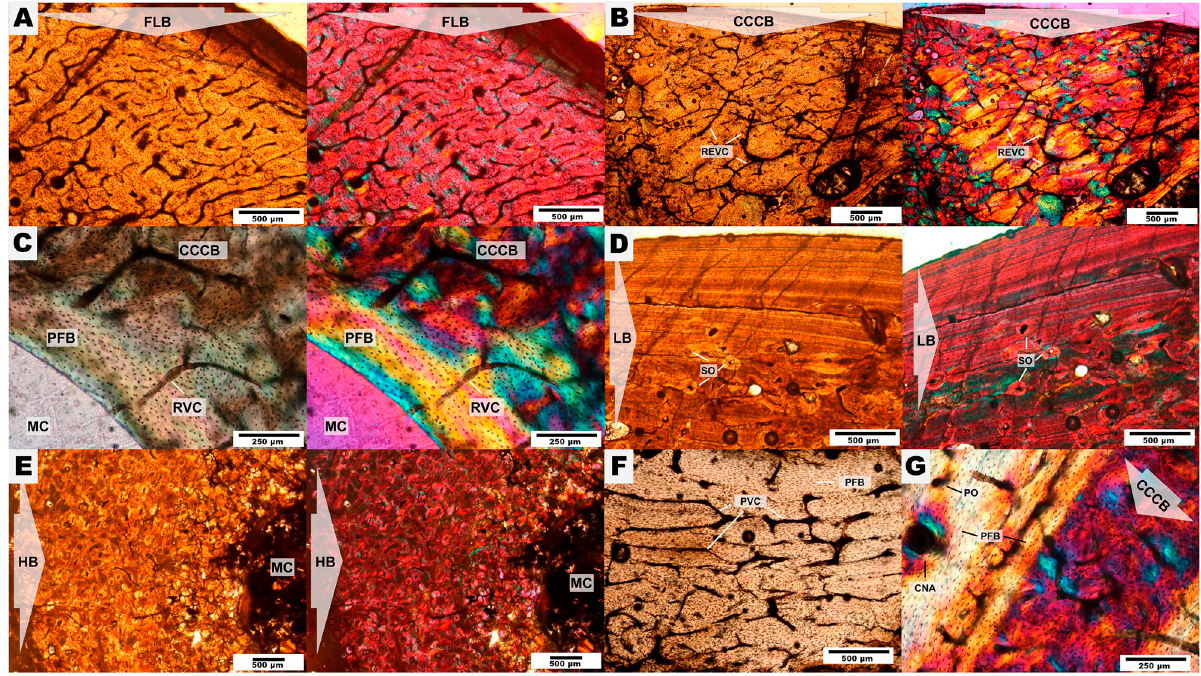
Fig 4. Bone tissue types observed in Caraguatypotherium munozi . (A) Fibrolamellar bone (FLB);(GEOUACH.HS.UD.1); (B) Compacted coarse cancellous bone (CCCB) and reticular vascular canals (REVC);(GEOUACH.HS.UD.1); (C) Parallel fibered bone (PFB), radial vascular canals (RVC) and compacted coarse cancellous bone (CCCB);(GEOUACH.HS.PFD.1); (D) Lamellar bone (LB) and secondary osteons (SO);(GEOUACH.HS.TI.2); (E) Haversian bone (HB);(GEOUACH.HS.FI.2); (F) Plexiform vascular canal (PVC) and parallel fibered bone (PFB);(GEOUACH.HS.UD.1); (G) Primary osteon (PO), Parallel fibered bone (PFB), Canal of the nutrient artery (CNA) and Compacted coarse cancellous bone (CCCB);(GEOUACH. HS.PFD.1).